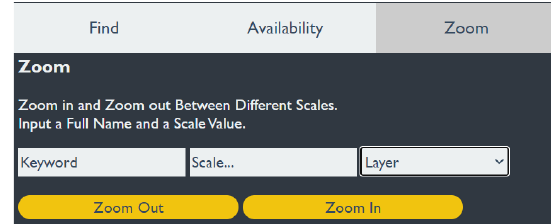
Figure 6 . (a)Find all representations of Lac St. Jean. (b)A fuzzy query that finds representations containing “A” in name.